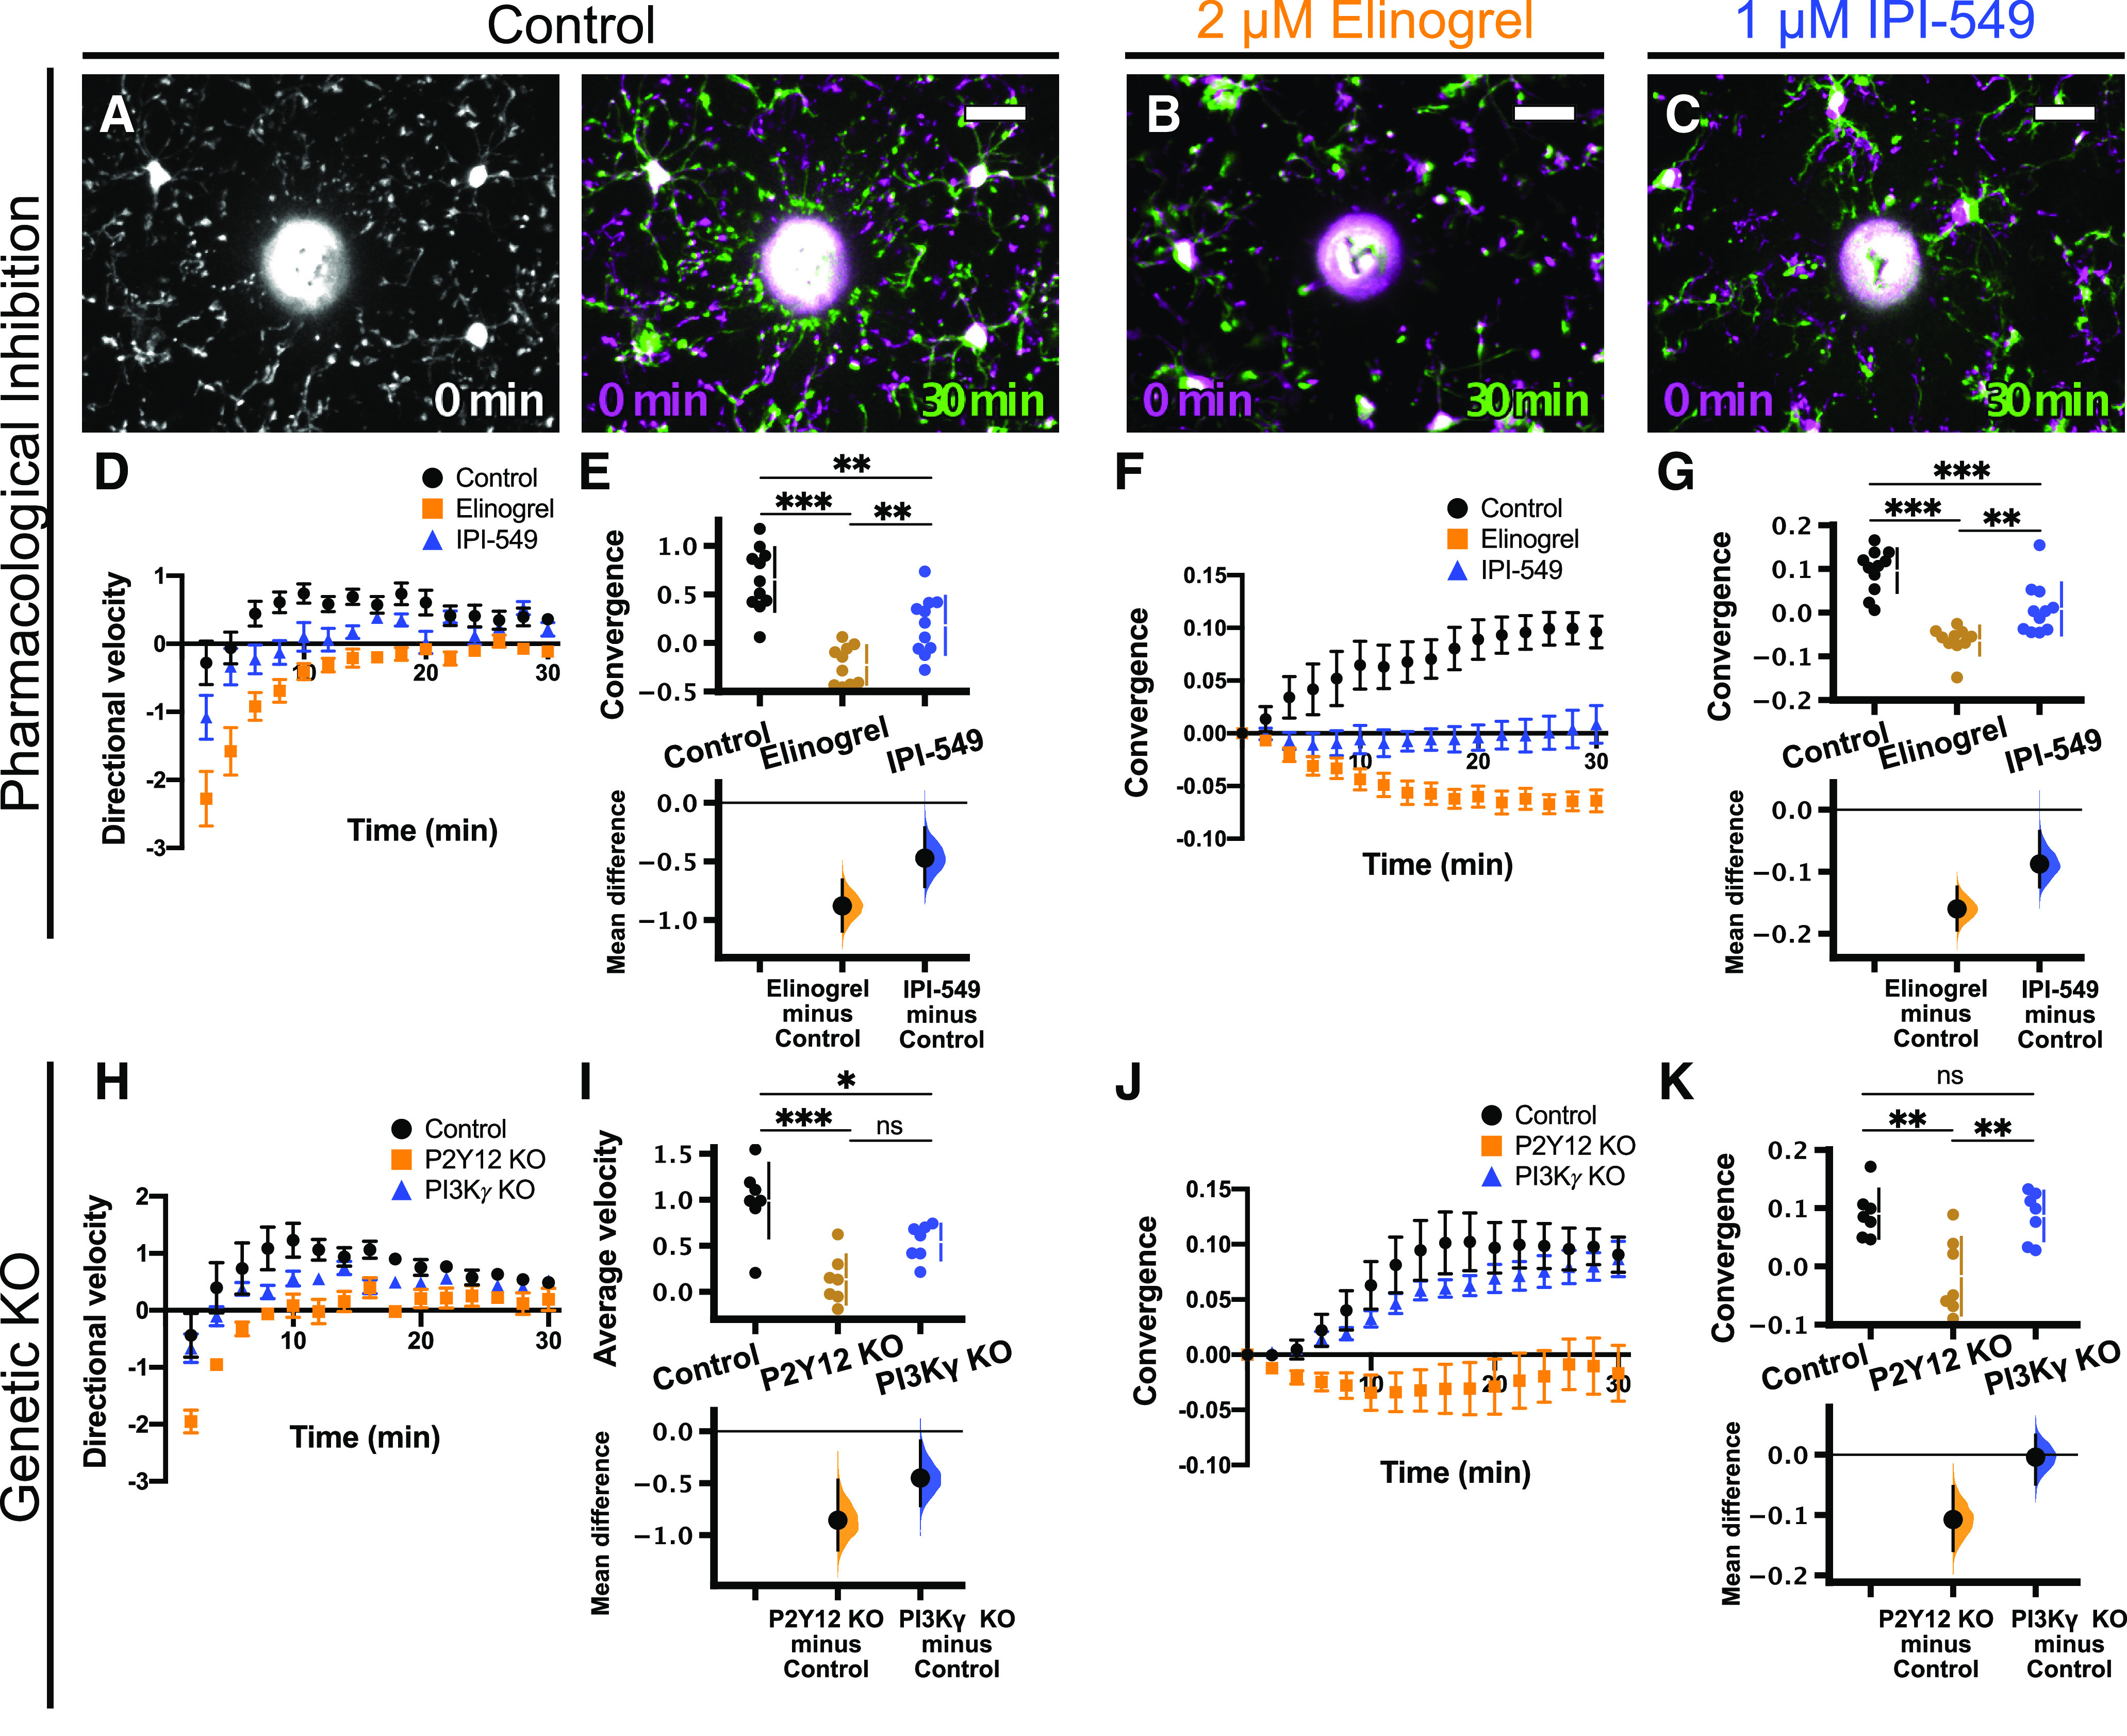
PI3Kγ is not required for the microglial response to laser injury in acute cortical slices. Representative images of the microglial response to laser injury in control (A), 2 μm elinogrel-treated (P2Y12 inhibitor; B), and 1 μm IPI-549-treated (PI3Kγ inhibitor; C) slices at the time points indicated. Images at 30 min after injury (green) are overlaid with initial images (t = 0 min, magenta). D–G, Effects of 2 μm elinogrel (orange squares) or 1 μm IPI-549 (blue triangles) on the microglial response to laser injury [n (slices) = 11 control, 10 elinogrel, 11 IPI-549 from 11 animals total]. D, Time course of directional velocity, one frame every 2 min. Note that the negative directional velocity that occurs soon after ablation is an artifact of tissue deformation following the laser injury. E, IPI-549 partially inhibits the directional response, whereas elinogrel completely blocks it [average velocity quantified at the interval of 10–20 min after injury; one-way ANOVA p < 0.0001; Tukey’s test: control vs elinogrel p < 0.0001; control vs IPI-549 p = 0.0014; elinogrel vs IPI-549 p = 0.0071; mean differences vs controls: elinogrel −0.88 (95%CI −1.1, −0.659); IPI-549 −0.472 (95%CI −0.715, −0.214)]. F, Time course for convergence. G, IPI-549 has an intermediate effect on convergence at 30 min, while elinogrel completely blocks convergence [one-way ANOVA p < 0.0001; Tukey’s test: control vs elinogrel p < 0.0001; control vs IPI-549 p = 0.0007; elinogrel vs IPI-549 p = 0.0059; mean differences vs controls: elinogrel −0.16 (95%CI −0.194, −0.125); IPI-549 −0.0876 (95%CI −0.125, −0.035)]. H–K, Effects of P2Y12 KO (orange) or PI3Kγ KO (blue) on microglial response to focal injury [n (animals) = 7 control, 7 P2Y12 KO, 7 PI3Kγ KO]. H, Time course for directional velocity. I, P2Y12 KO and PI3Kγ KO reduce the directional velocity compared with control [comparison based on average velocity in the interval of 10–20 min after injury; one-way ANOVA p = 0.0002; Tukey’s test: control vs P2Y12 KO p = 0.0001; control vs PI3Kγ KO p = 0.031; P2Y12 KO vs PI3Kγ KO p = 0.054; mean differences vs controls: P2Y12 KO −0.856 (95%CI −1.14, −0.47); PI3Kγ KO −0.45 (95%CI −0.717, −0.0926)]. J, Time course for convergence. K, P2Y12 KO decreases convergence at 30 min, while PI3Kγ KO has no effect [one-way ANOVA p = 0.0014; Tukey’s test: control vs P2Y12 KO p = 0.0030; control vs PI3Kγ KO p = 0.99; P2Y12 KO vs PI3Kγ KO p = 0.0041; mean differences vs control: P2Y12 KO −0.107 (95%CI −0.159, −0.0526); PI3Kγ KO −0.00402 (95%CI −0.0487, 0.0325)]; ns, non-significant; *p < 0.05, **p < 0.01, ***p < 0.001. Data presented as mean ± SEM. Scale bar: 20 μm.